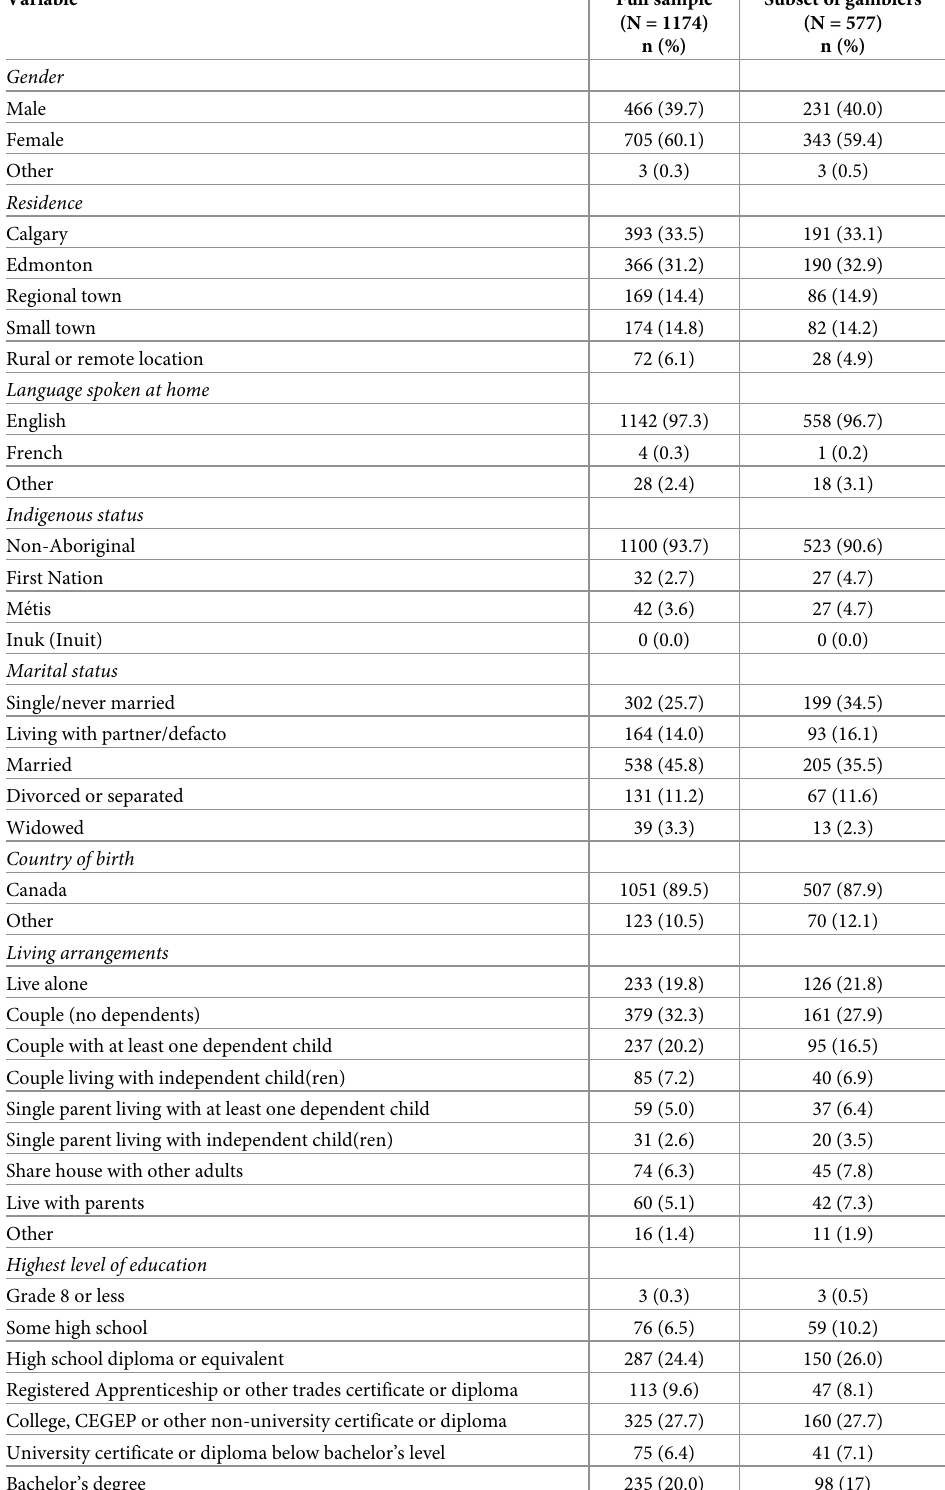
Table 1. Demographic characteristics of the full sample and the